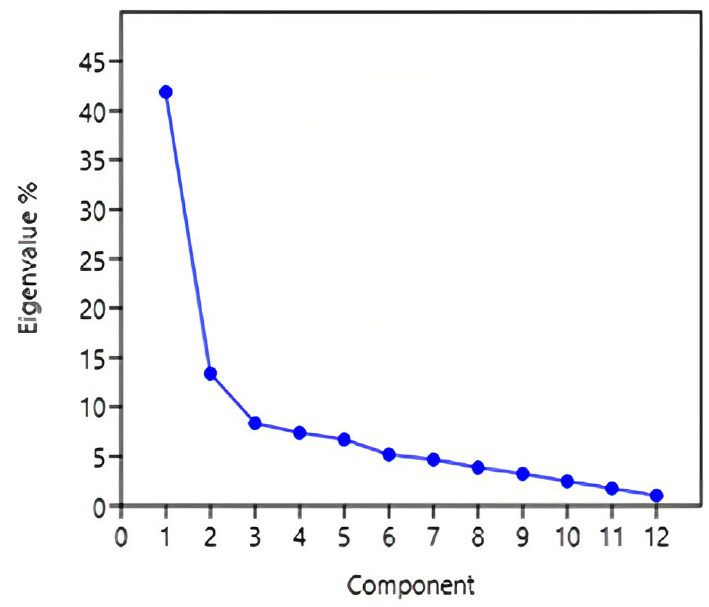
Figure 3. Principal component analysis of the translated MISS score.